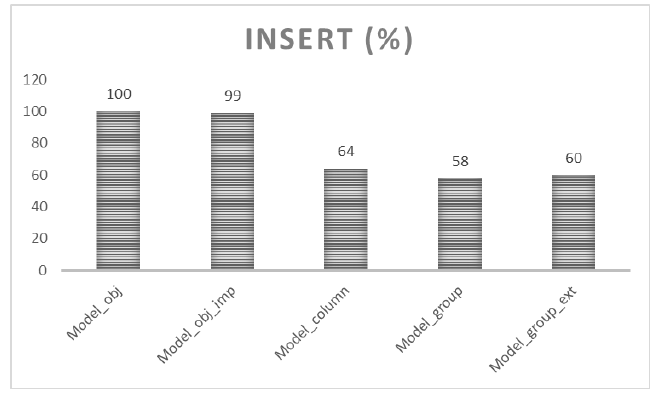
Figure 21. Data loading (Insert statement).